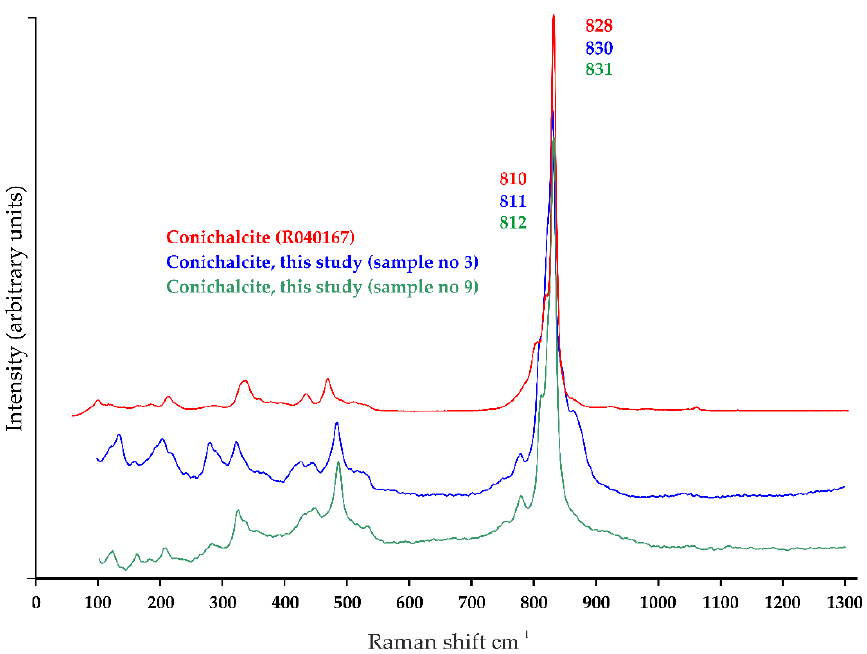
Figure 10. Reference spectra of conichalcite, with the spectra measured in samples 3 and 9.